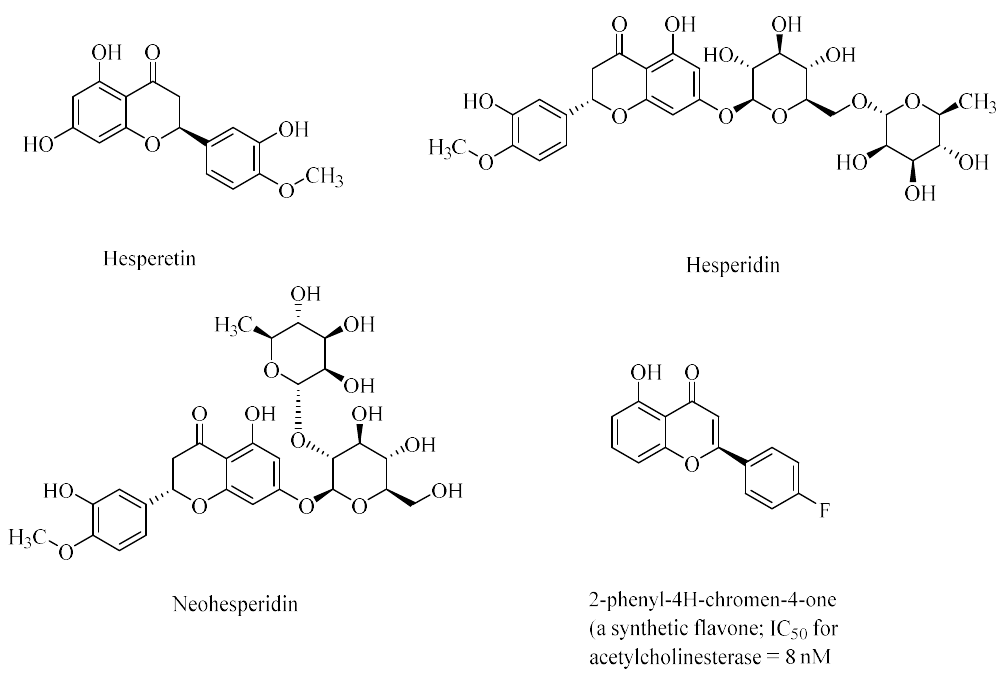
Figure 2. Structures of citrus flavanones, hesperitin, hesperidin, and neohesperidin and a synthetic